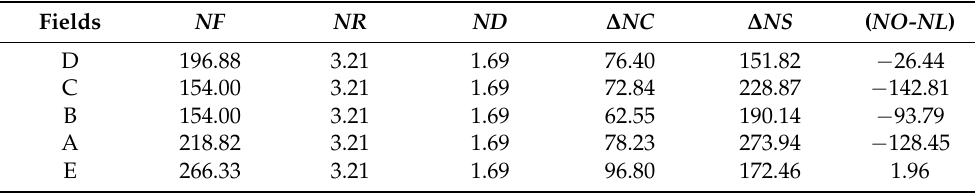
Table 6. Calculation of the nitrogen balance during the entire growth period of cotton (kg/ha).